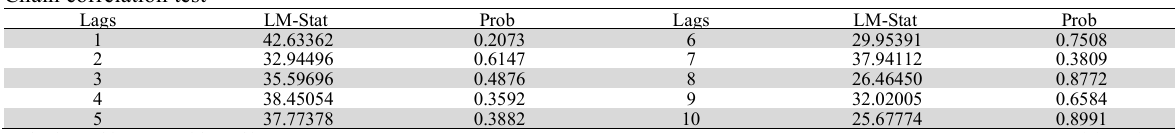
Chain correlation test